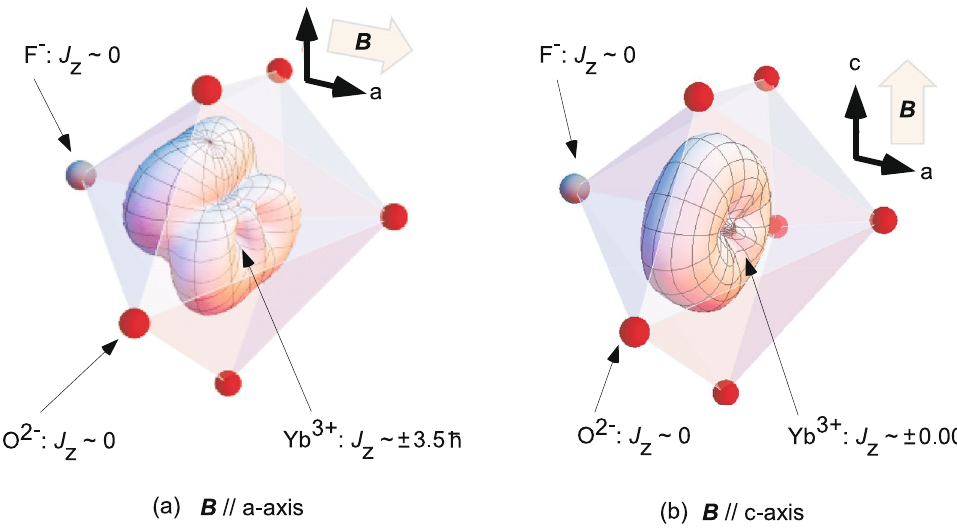
Figure 1. Dependence of the shape of Yb 3 + in the crystal field on the direction of an applied magnetic field. Yb 3 + is surrounded by one F − (gray spheres) and six O 2 − ions (red spheres), which is the same as the 6 h site in FAP (bold arrows indicate the crystal axes of FAP). The dependence of the shape of Yb 3 + in the crystal field on the direction of the applied magnetic field causes the anisotropy of the total angular momentum of 4 f electrons in RE 3 + along the applied magnetic field J z .